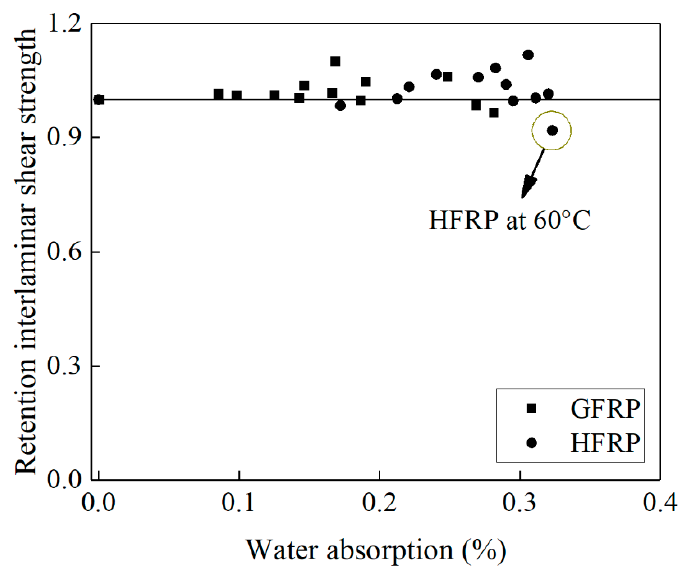
Figure 10. The effect of water absorption on the interlaminar shear strength of the FRP